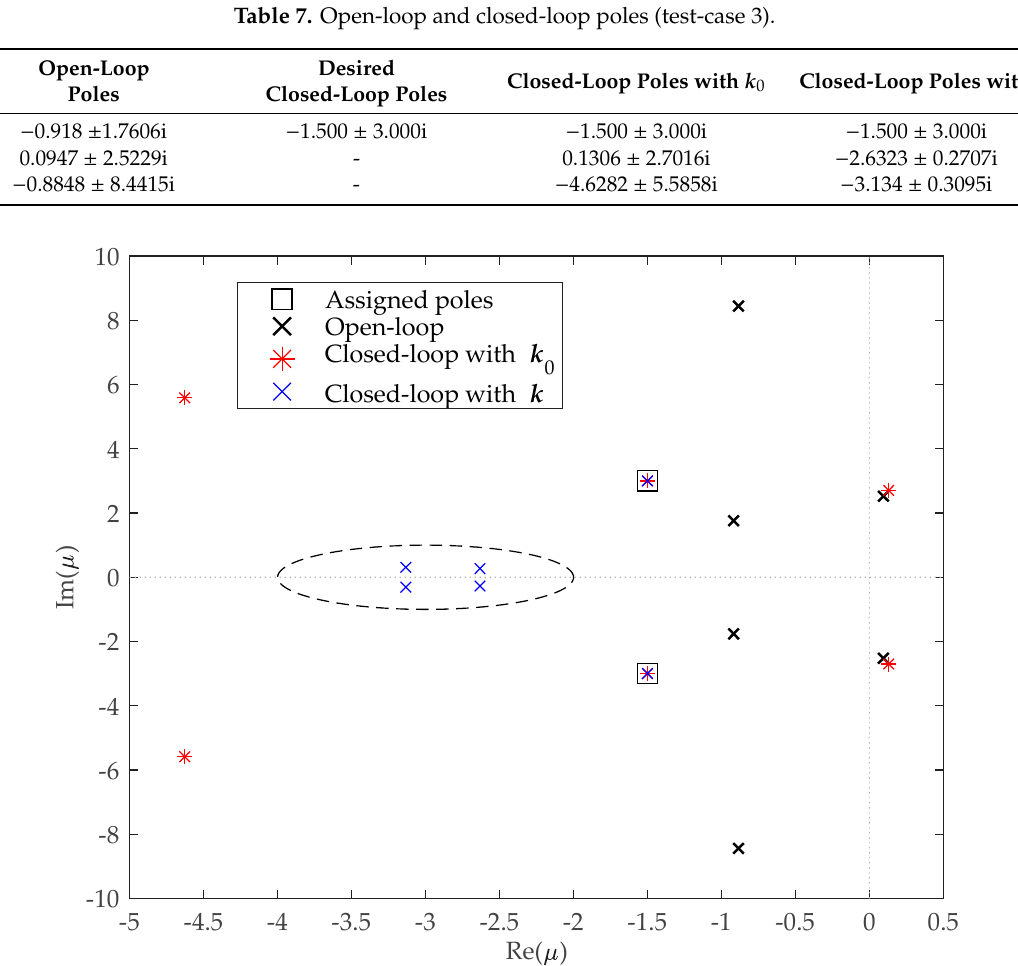
Figure 9. Open-loop and closed-loop poles of the aircraft wing under an air stream (test-case 3).